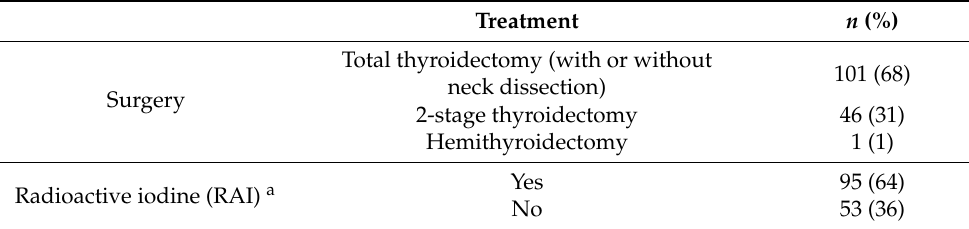
Table 2. Thyroid cancer